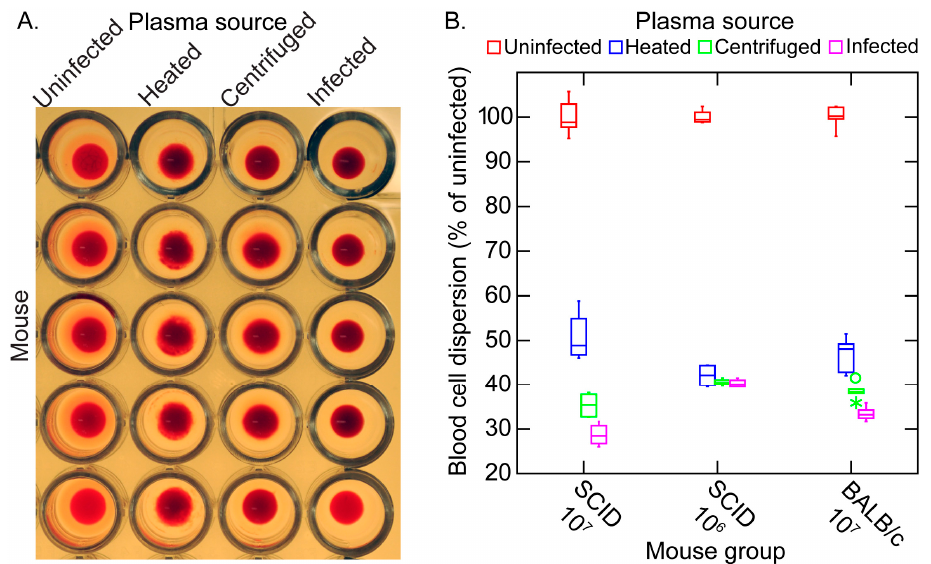
Figure 11. In vitro erythrocyte aggregation assay of uninfected blood mixed with plasma from uninfected mice and plasma from infected mice that was unaltered (infected), centrifuged, or centrifuged and heated. The assay method is described in the text. ( A ) Panel A shows a microtiter plate for which the source of plasma was from immunocompetent BALB/c mice (five uninfected or five infected); ( B ) Panel B is a box-whisker graph of the blood cell dispersion as estimated by image analysis and expressed as the percentage of each of four experimental conditions’ values to the mean of the uninfected values. The 12 infected SCID mice were divided into a group of eight with a high spirochete burden (10 7 cells/mL) and a group of four with a moderate spirochete burden (10 6 cells/mL) in the plasma. There were five infected BALB/c mice.